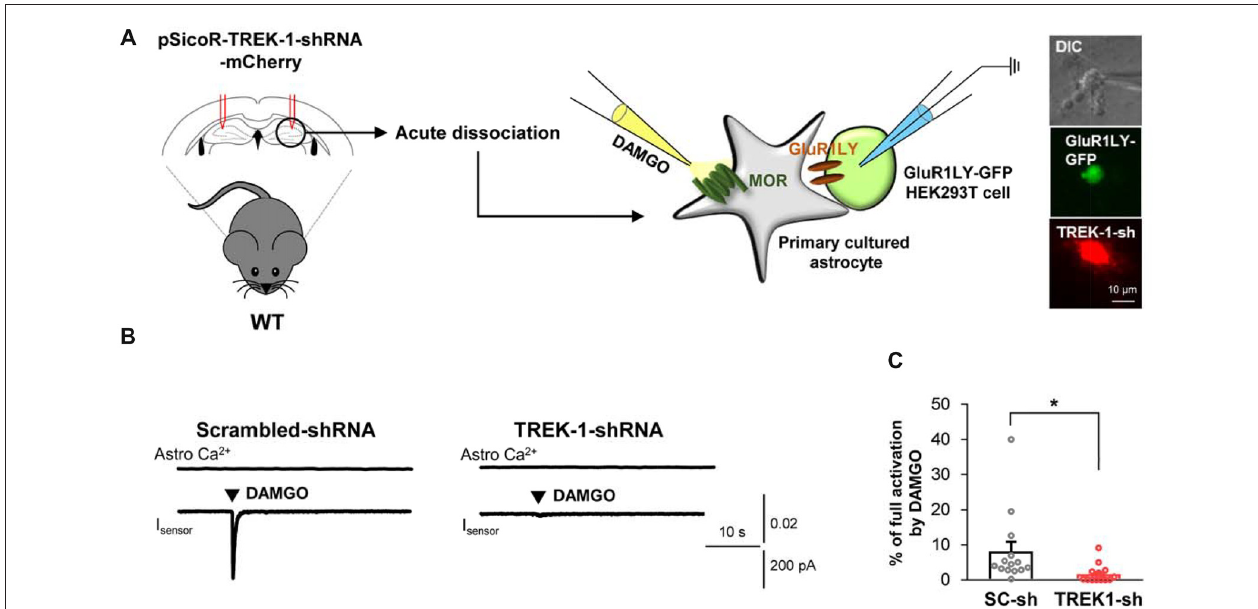
FIGURE 3 | Astrocytic glutamate release upon MOR activation is mediated by TREK-1. (A) Left, schematic diagram of sniffer-patch with acutely dissociated astrocytes from pSicoR-TREK-1-shRNA-mCherry-injected hippocampus and GluR1LY-GFP-expressing HEK cells. Right, differential interference contrast image and fluorescent image of GluR1LY-GFP-expressing HEK cell (green) and TREK-1-shRNA-mCherry-infected hippocampal astrocyte (red). (B) Representative traces of Ca 2 + response and inward current in acutely dissociated hippocampal astrocyte of scrambled-shRNA and TREK-1-shRNA-injected mouse. (C) Summary bar graph for DAMGO-induced glutamate current normalized by the full activation current in scrambled shRNA and TREK-1-shRNA-injected mice. Data from at least three independent mice for each group. Unpaired two-tailed t -test with Welch’s correction ( ∗ P <